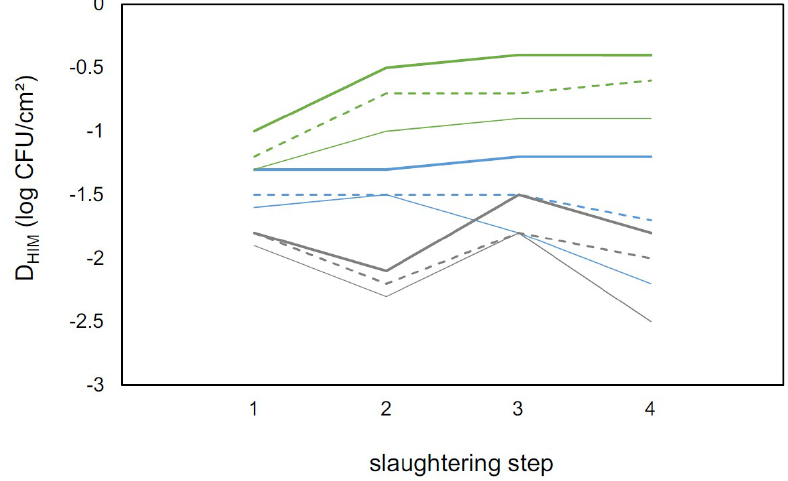
Figure 3. Differences between the microbial counts (log CFU/cm 2 ) of MA and a given hygiene indicator microorganism (D HIM ; Enterobacteriaceae: Dot lines; Total coliforms; dash lines; and Escherichia coli : Continuous line) in different steps of slaughtering (step 1: Hide after bleeding; step 2: After hide removal; step 3: After evisceration; and step 4: After end washing) in eight slaughterhouses located in three Brazilian states (Minas Gerais: Blue lines; Paraná: Grey lines; and Rio Grande do Sul: Green lines).